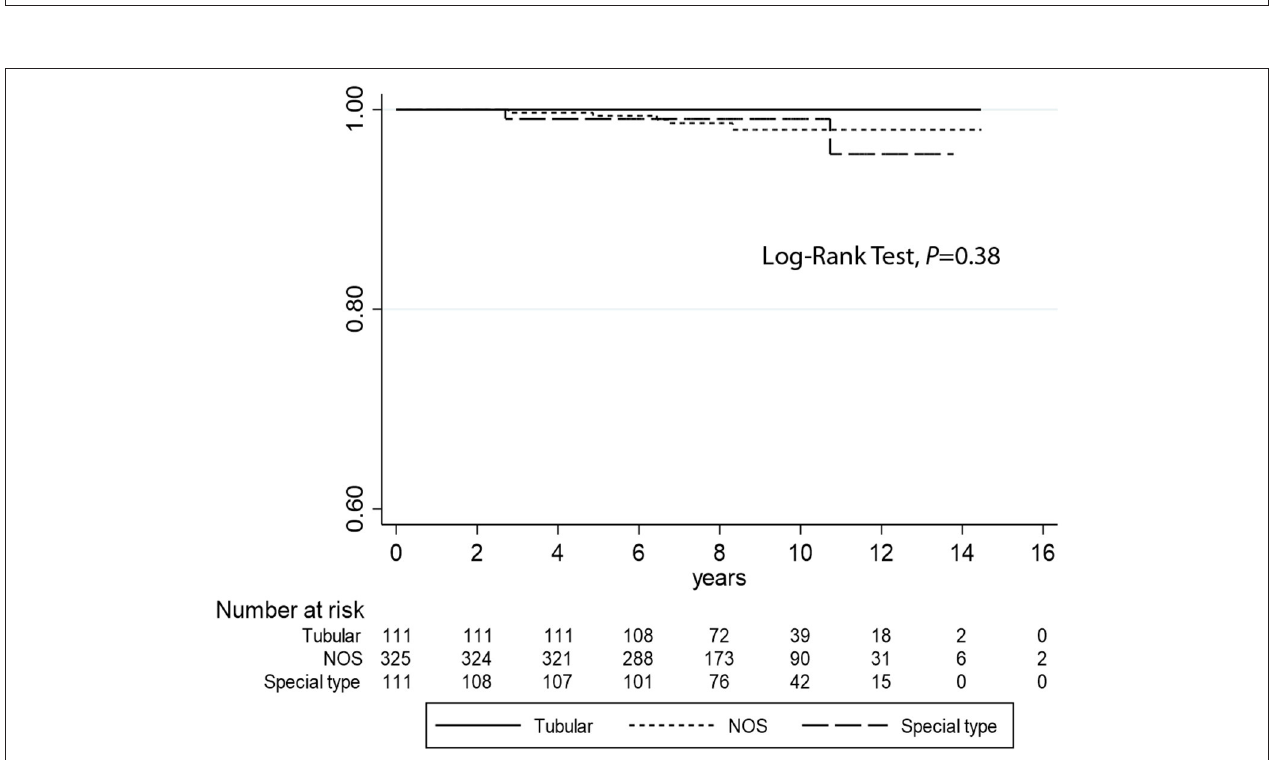
FIGURE 3 | Kaplan–Meier estimates of DSS (log-rank test, P = 0.38) comparing tubular carcinomas with the other histotypes (not otherwise specified and special type breast cancers).